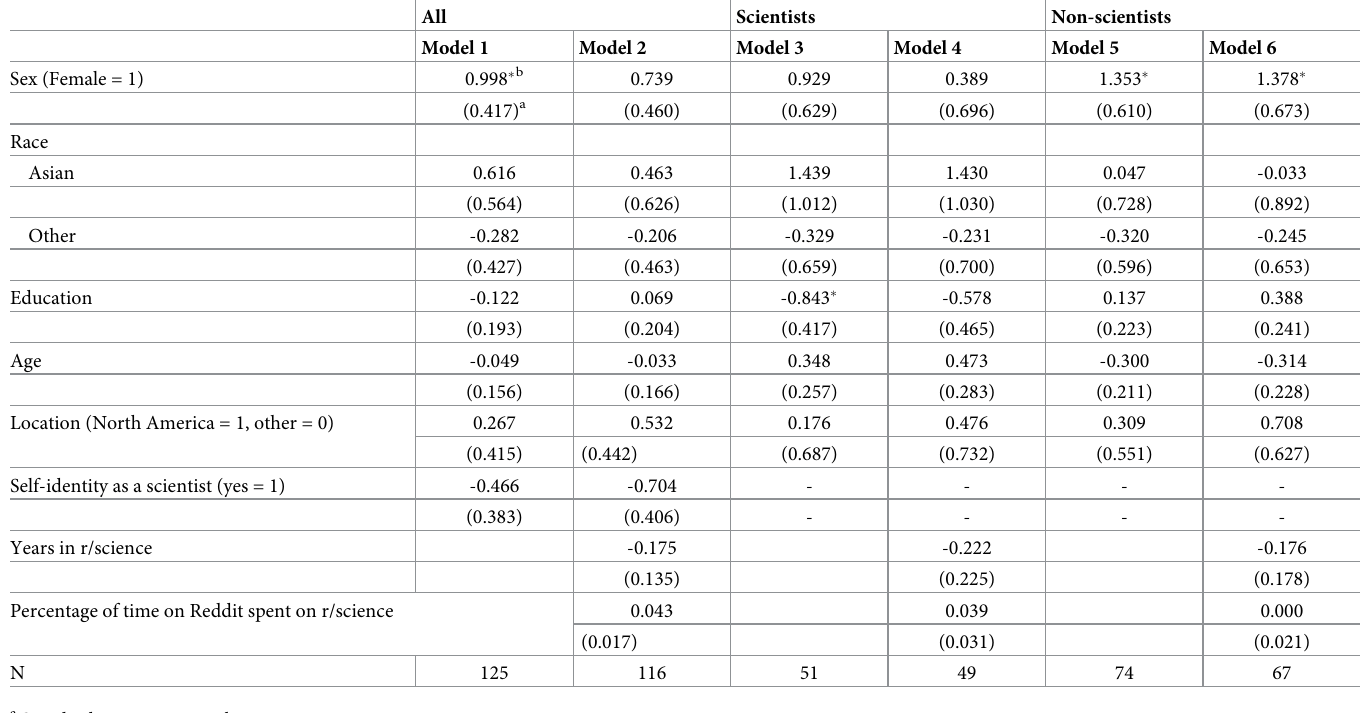
Table 8. Results of ordinal logistic regression of users’ demographics on the perceived effect of r/science in helping built trust for science.